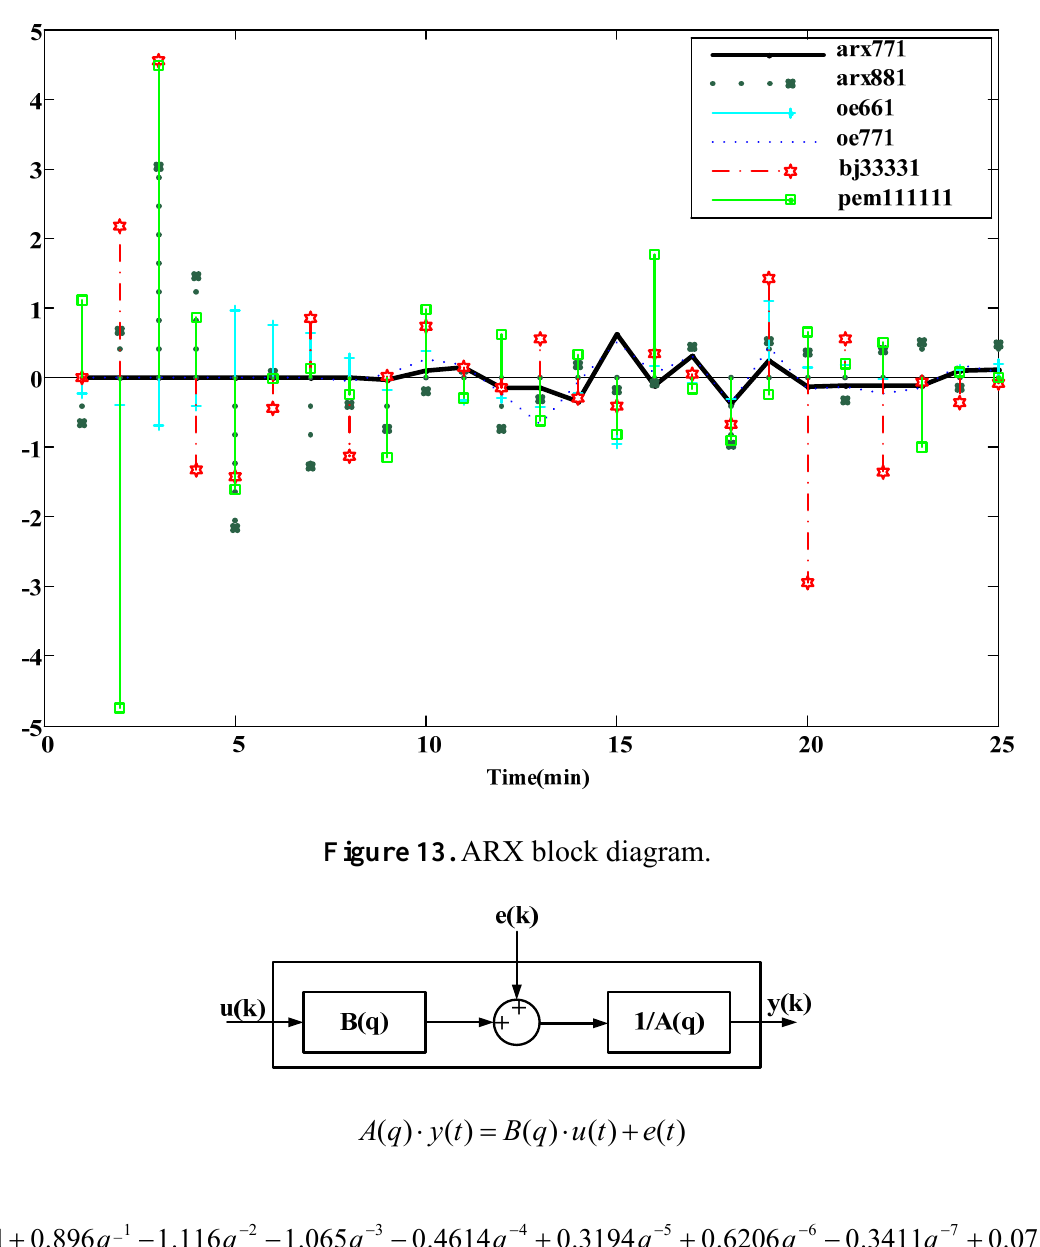
Figure 12. Results of residual analysis of the models.